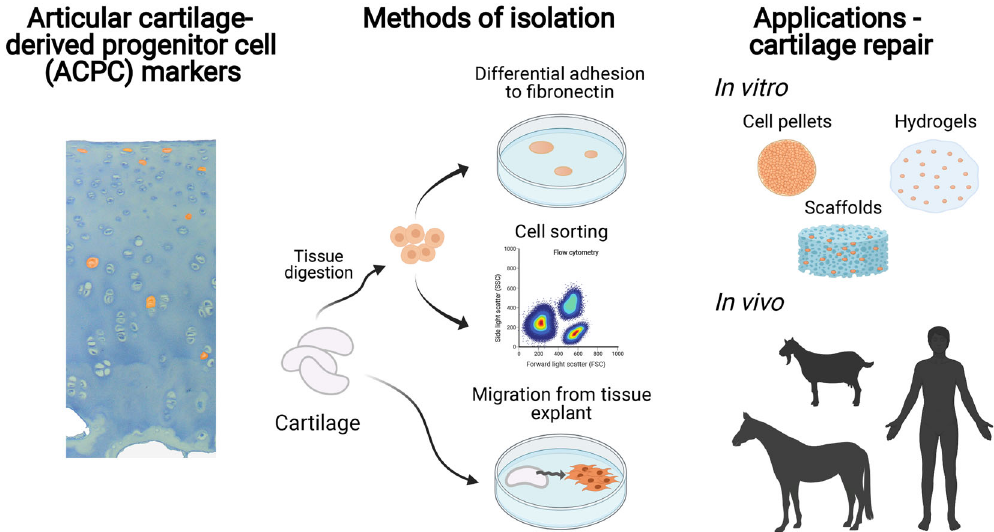
Fig. 2 Isolation, characterization, and application of articular cartilage-derived progenitor cells. Schematic overview of the identi fi cation of articular cartilage-derived progenitor cells (ACPCs) in cartilage, isolation methods, and applications of ACPCs. Created with